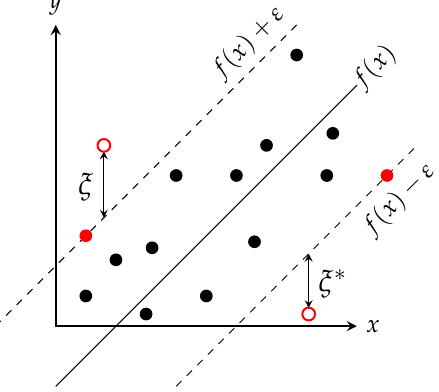
Figure 1. Support vector regression: ε